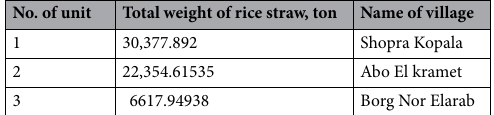
Table 1. The three sites in Sinbilawin